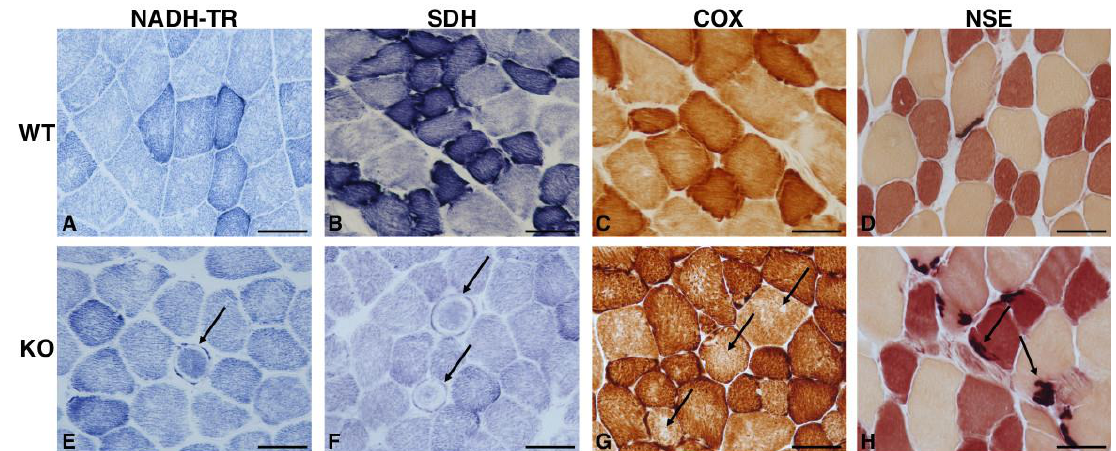
Figure 3. Characterization of Hipk2 -KO skeletal muscle. Histochemical analysis of NADH-TR ( A , E ), SDH ( B , F ), COX ( C , G ), NSE ( D , H ) on sections of skeletal muscle of 18-month-old WT and Hipk2 -KO mice are shown. Arrows in ( E , F ) indicate the presence of numerous ring fibers with subsarcolemmal positive deposits; arrows in ( G ) indicate negative cytoplasmic core; arrows in ( H ) indicate hypertrophic and fragmented neuromuscular junctions. Original magnification, 40×. Scale bar = 20 μm.